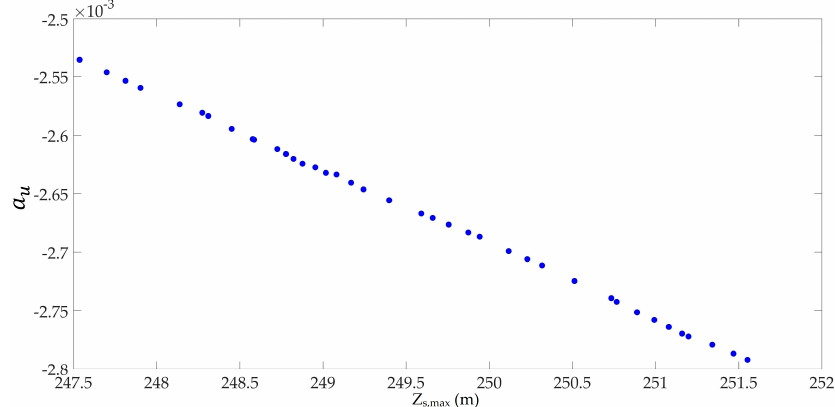
Figure 10. Pareto front for upsurge. Table 4. Sensitivity analysis with di ff erent population